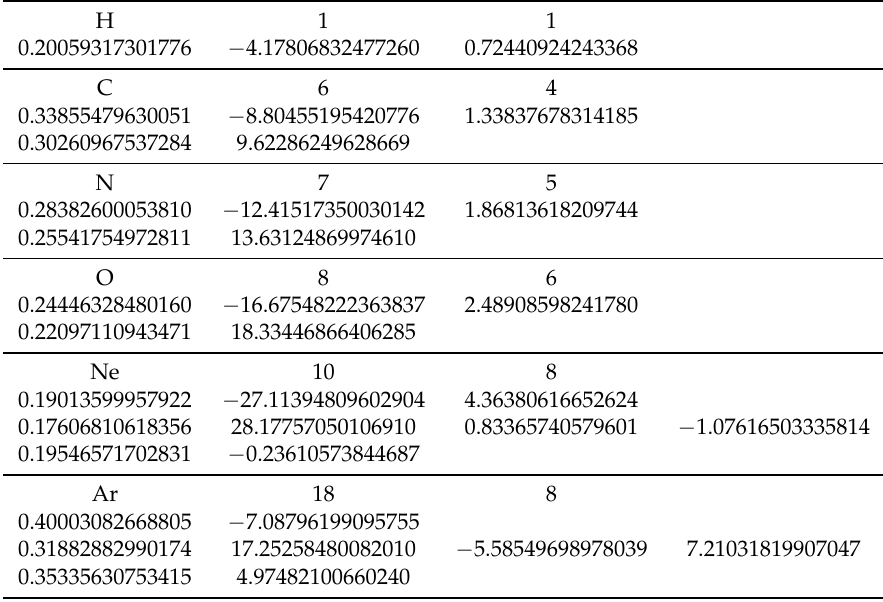
Table A1. PBE pseudopotential parameters. The format corresponds to [78]. Pseudopotentials are taken from